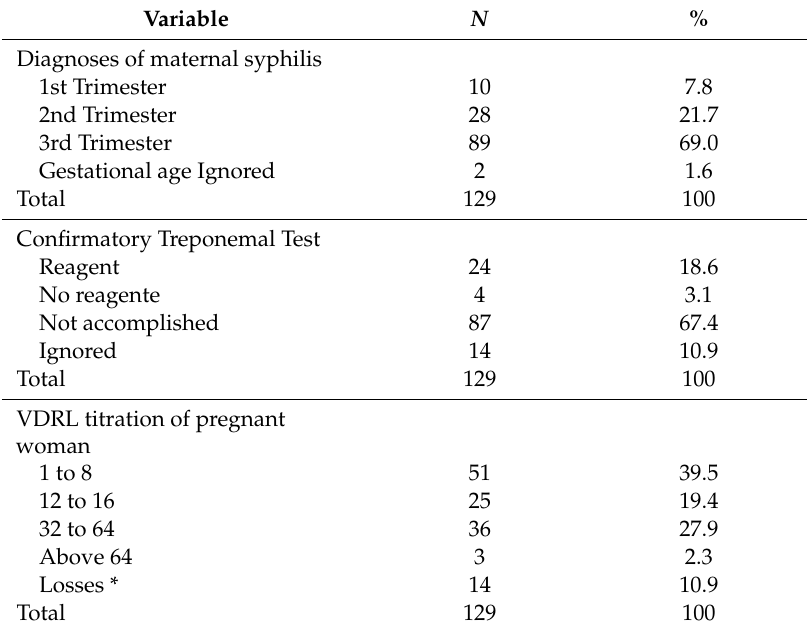
Table 1. Time of diagnosis and laboratory aspects of detection of gestational syphilis. Natal, RN, Brazil, 2016 ( n = 129 pregnant